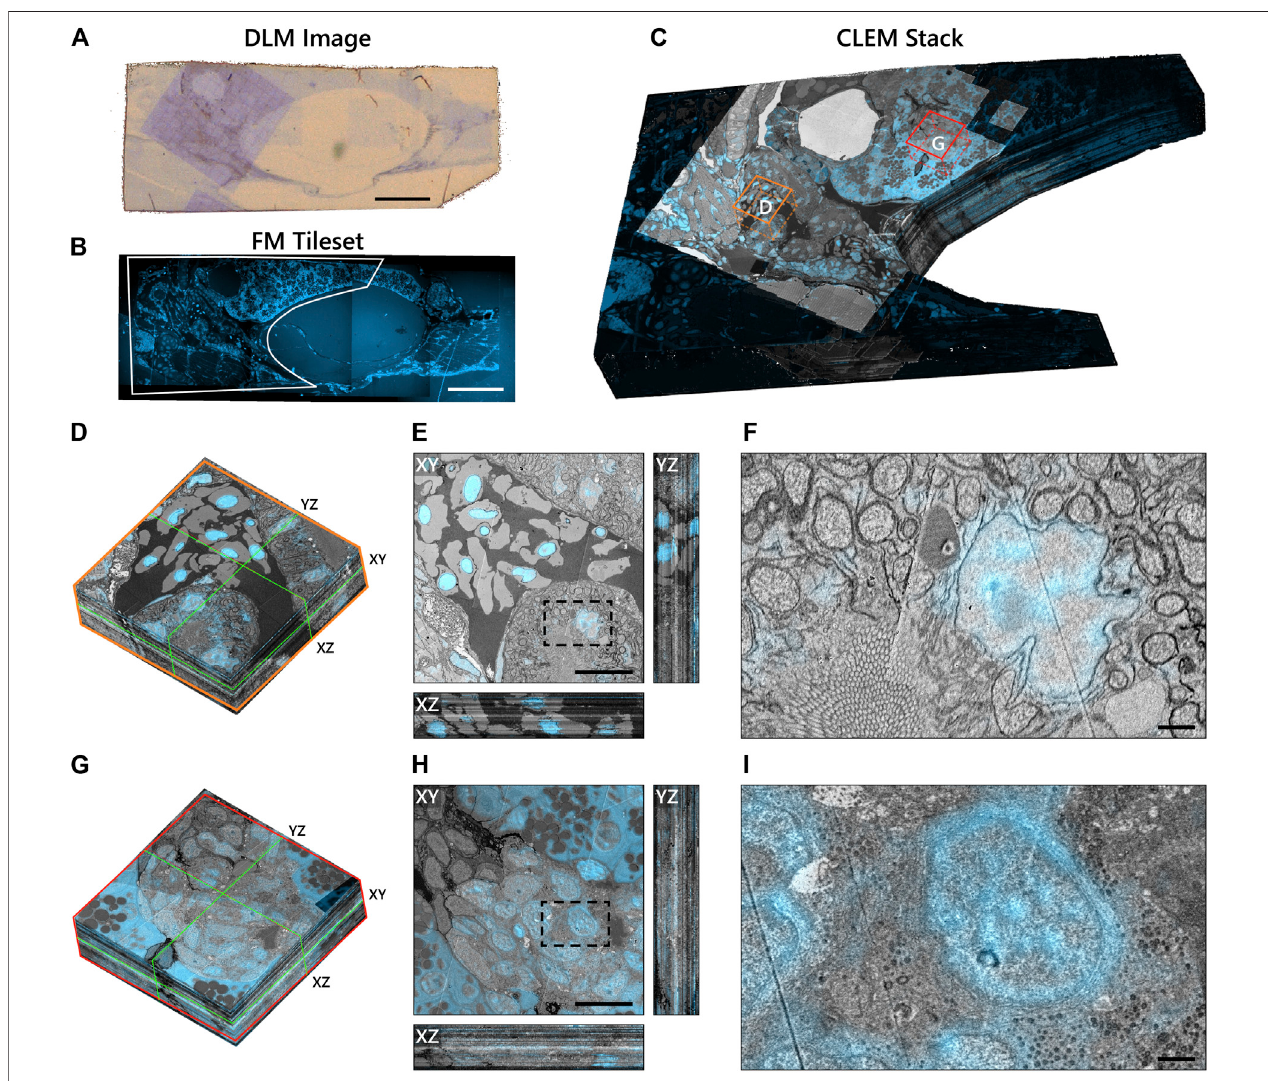
FIGURE6| Integrated correlative arraytomographyappliedto63serialsections ofzebra fi sh pancreas. (A) Contrast-enhanced optical image ofanindividual serial section obtained by the DLM. The section was re-acquired post-EM imaging, revealing the region of interest irradiated by the electron beam. The biological material can beseeninpaleblueincontrastwiththebareEPON(brownbackground). (B) Hoechstsignalofanindividualserialsection,outlining(white)theportionofthetissueshown in (C) . (C) CLEM volume of the zebra fi sh tissue cropped to the ROI selected for high-magni fi cation EM imaging — plus a portion of the surrounding fl uorescence signal.Sub-stacksforinspectionaredenotedbyorange (D – F) andred (G – I) boxes. (D) 3Dsub-stackofmuscletissuewithinthezebra fi shpancreas.Greenlinesindicate orthoslices of the XY, XZ, and YZ planes shown in (E) . (F) Zoomed-in region of the XY plane showing high-precision FM overlay of Hoechst onto a cell nucleus. (G – I) Sameasin (D – F) ,butforanisletofLangerhans.Ill-de fi nedcellandorganellemembranesin (H) and (I) indicatesuboptimalpreservationoftheultrastructureinthisregion of the pancreas. Scale bars: (A,B) 100 μ m; (E,H) 10 μ m; (F,I) 1 μ m. Raw data at full resolution is available via Nanotomy.